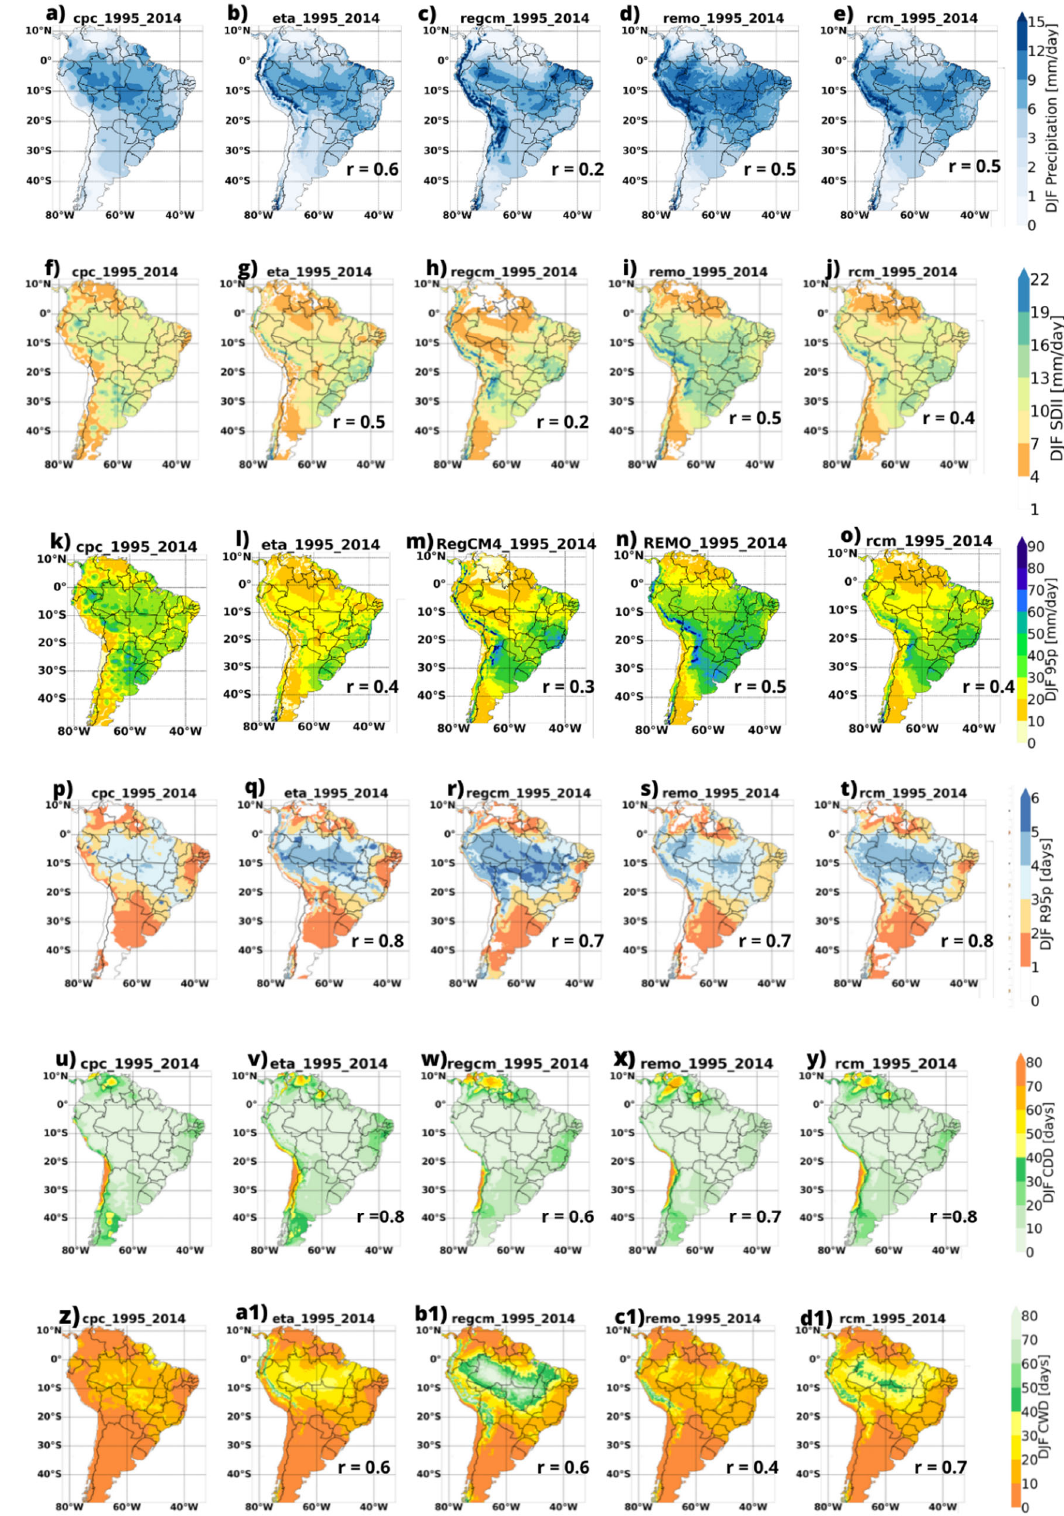
Figure 3. Climate indices calculated for the austral summer in the period of 1995–2014 using CPC (left column), each RCM ensemble (Eta, RegCM and REMO) and 3RCMs ensemble (right column): ( a – e ) PRCPTOT (mm/day), ( f – j ) SDII (mm/day), ( k – o ) P95 (mm/day), ( p – t ) R95p (days), ( u – y ) CDD (days), and ( z , a1 , b1 , c1 , d1 ) CWD (days). The values shown indicate the spatial correlation ( r ) between each ensemble and CPC.